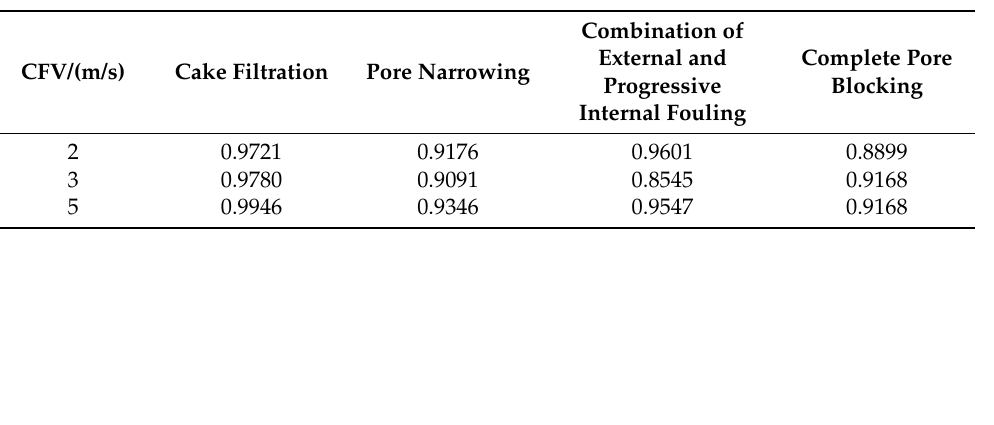
Table 7. R 2 values of regression by the different CFVs for four fouling